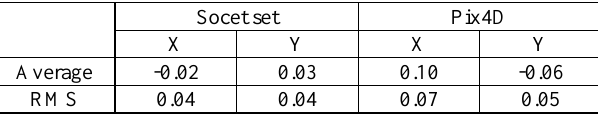
Table 4: Residuals statistics on control